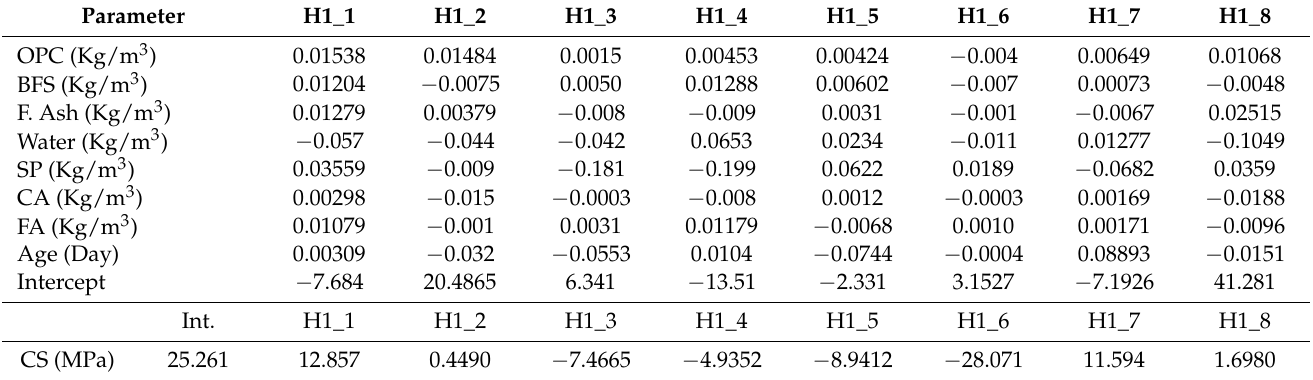
Figure 8. Actual by predicted plot ( a ); Residual by predicted plot ( b ) in training and validation phase of ANNs model. Table 4. Statistical parameter estimations using ANNs